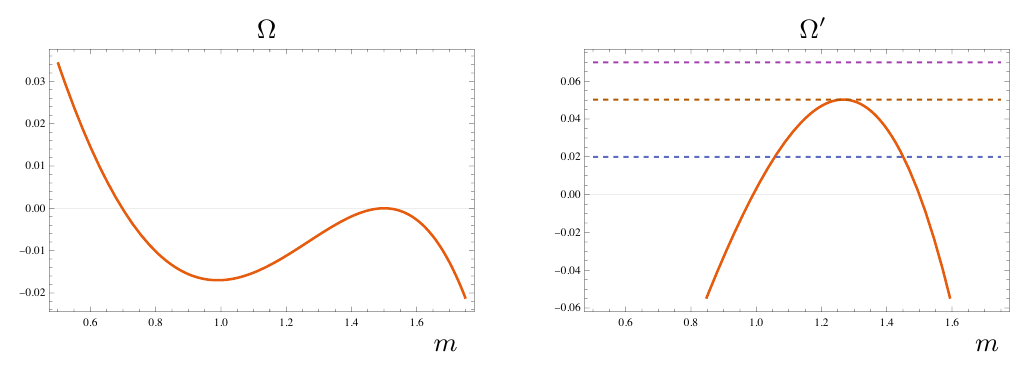
Figure 5 . The grand potential Ω( m ) (left) and its first derivative Ω 0 ( m ) (right) on the four-sphere. The function Ω( m ) is convex for m ≤ m 1 . 266 . . . , has a minimum for mr fl ≈ and a maximum for mr = m = 3 / 2 . The maximization condition admits two solutions 0 max r 0 for 0 ≤ Q < Q = Ω 0 ( m ) ≈ (2 N ) · 0 . 5029 . . . and no solutions beyond Q = Q fl fl leftmost solution gives a convex function, but does not satisfy F (0) = 0 since F (0) = − Ω( m 0 . 017 · · · > 0